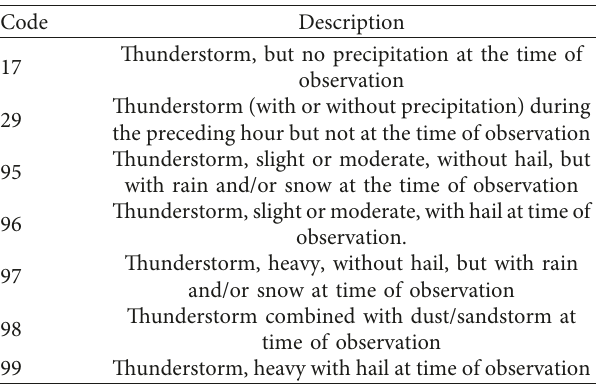
Figure 1: Distribution pattern of the studied stations. Table 1: Thunderstorm’s code and its description (source: WMO code 4677 1